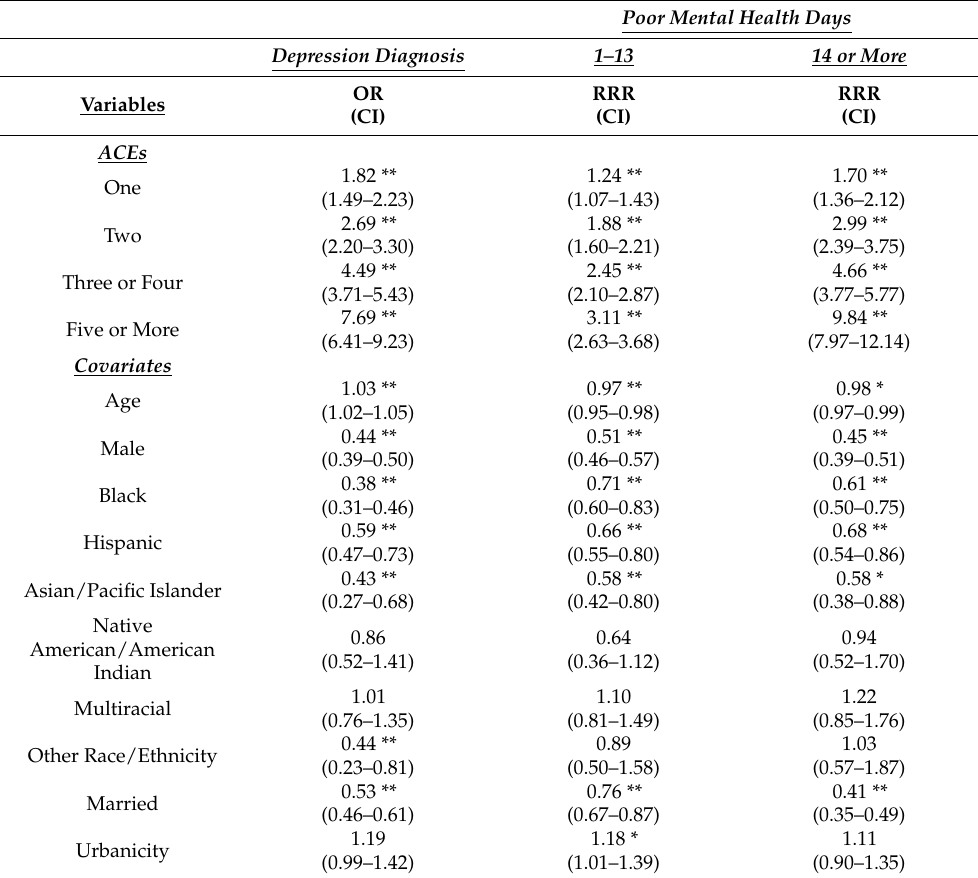
Table A6. Association between adverse childhood experiences and indicators of poor mental health among young adults aged 18–34 ( n =